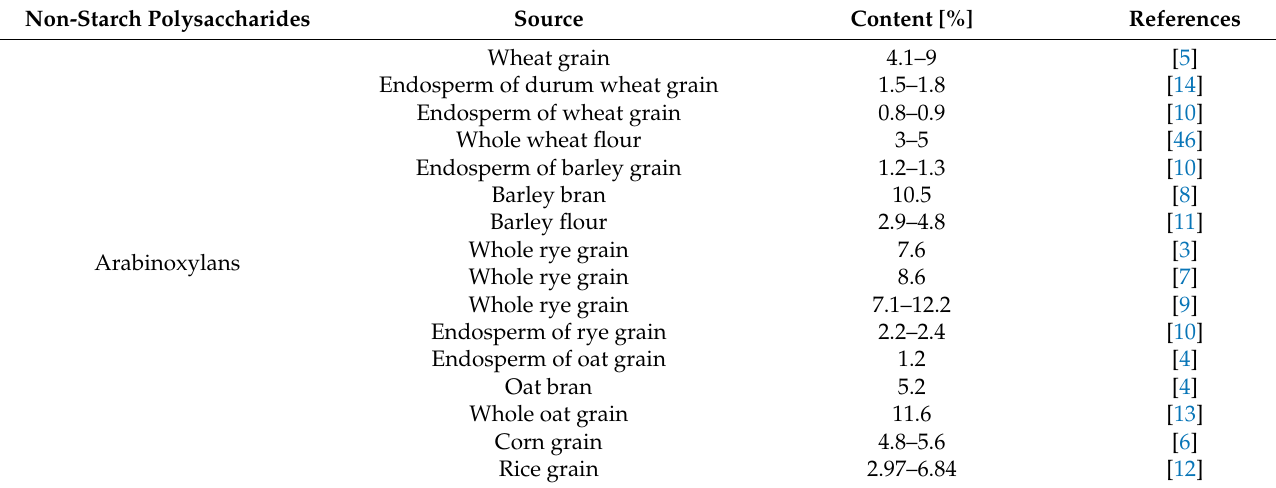
Table 1. Content of non-starch polysaccharides in cereal